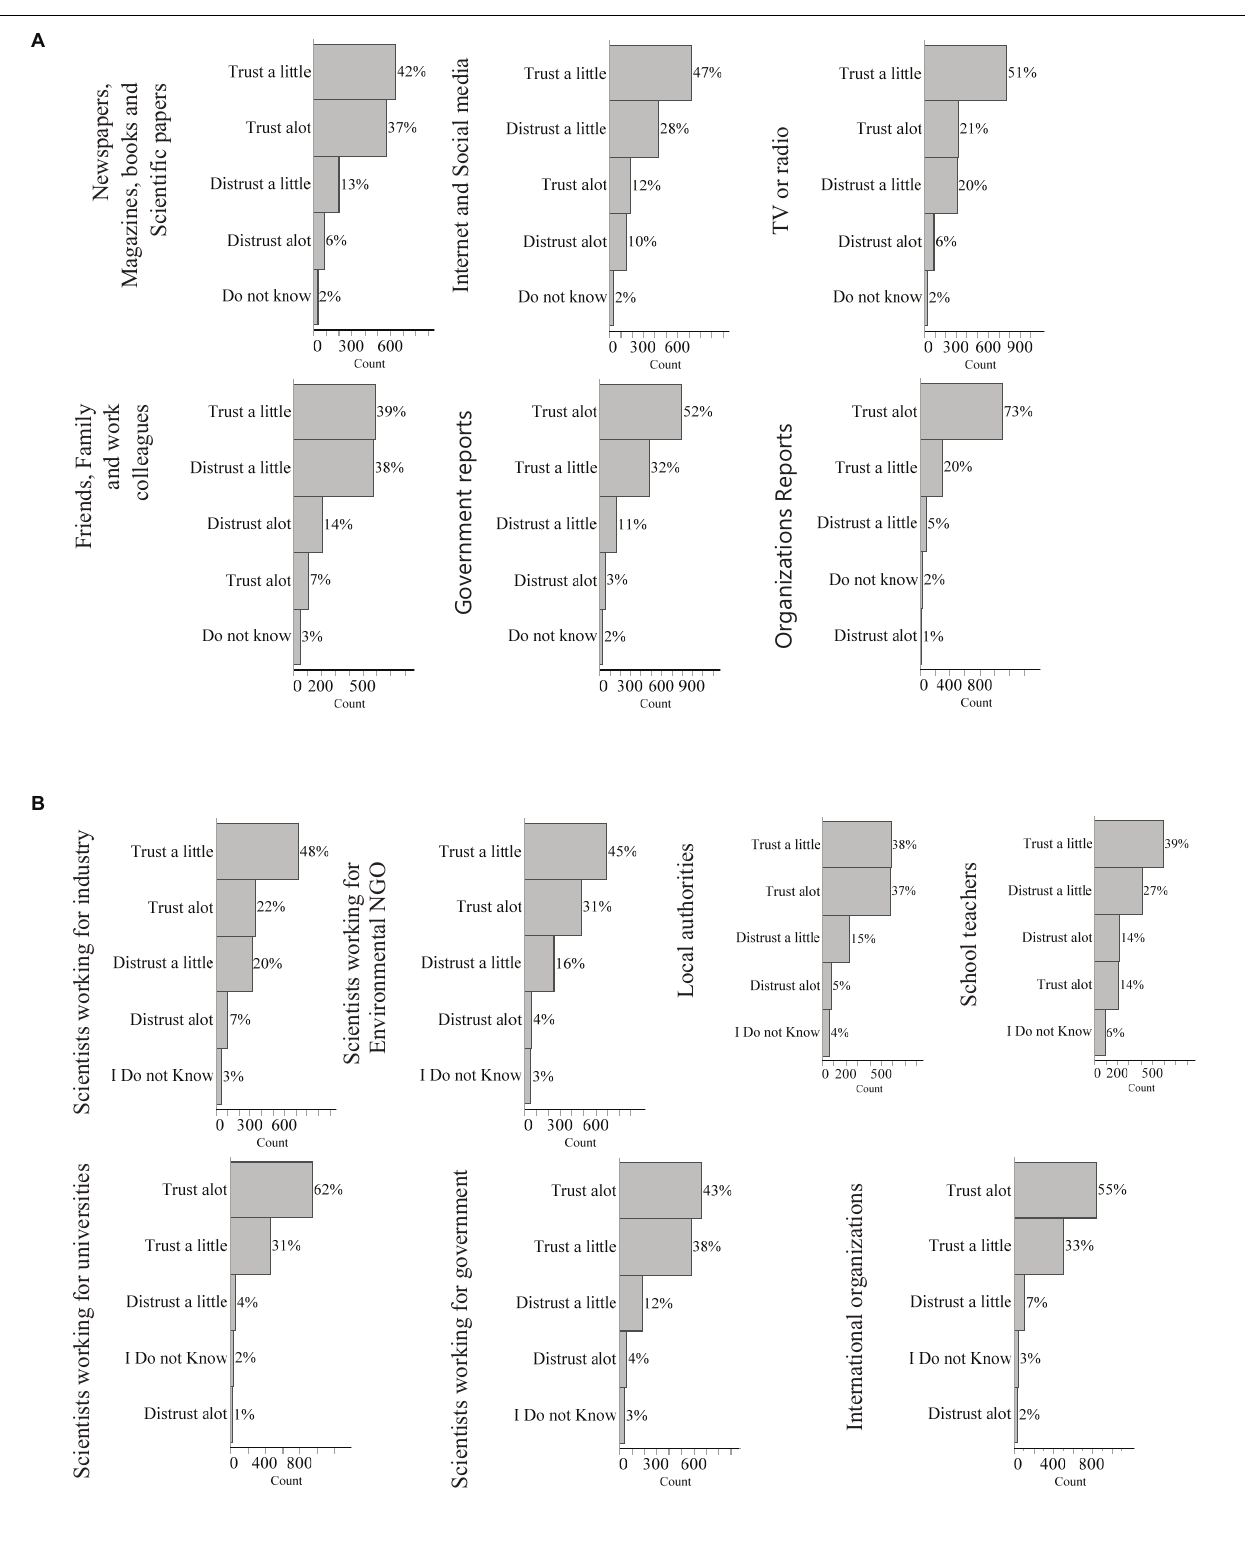
FIGURE 5 | (A) Responses to the question: To what extent, if at all, do you trust each of the following types of media when providing information about coastal environmental issues? (B) Responses to the question: To what extent, if at all, do you trust each of the following individuals or organizations when providing information about coastal environmental